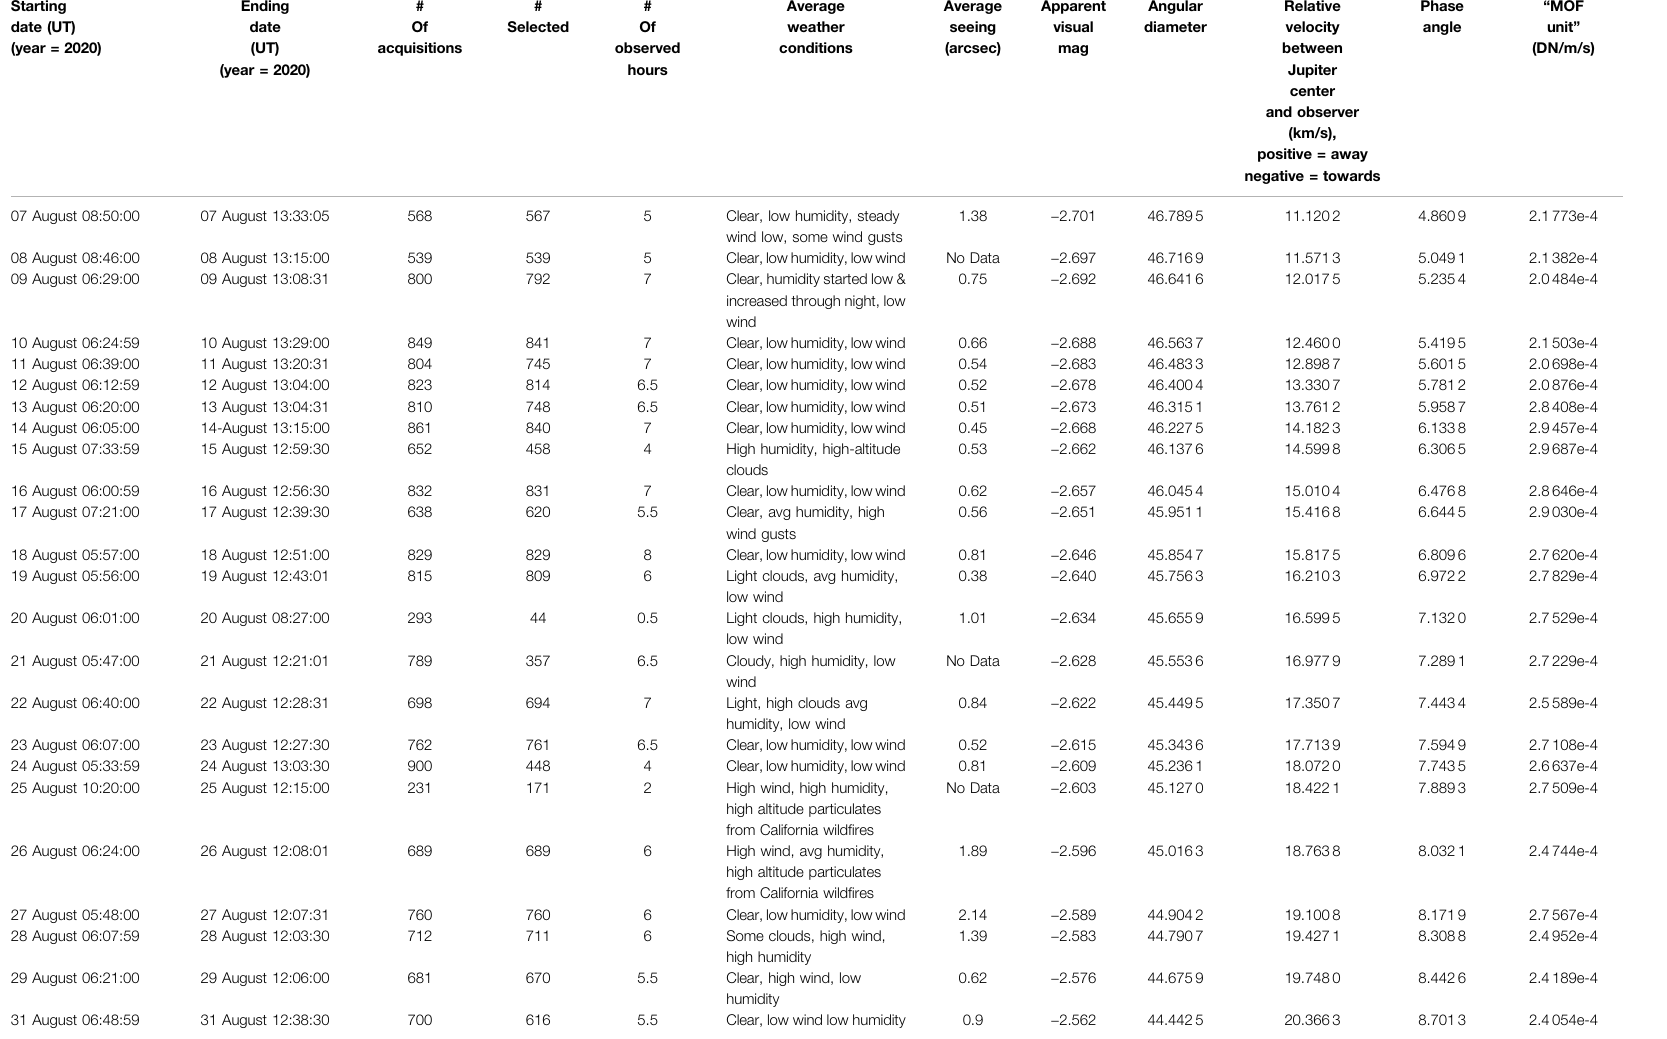
TABLE 1 | Jovian observation statistics collected during the summer 2020 PMODE observational campaign on the AEOS 3.6 m telescope. Low humidity is de fi ned as below 20%, high humidity is de fi ned as greater than 60%. All statistics pertain directly to Jupiter, as other observed targets are not considered within this paper. Starting date